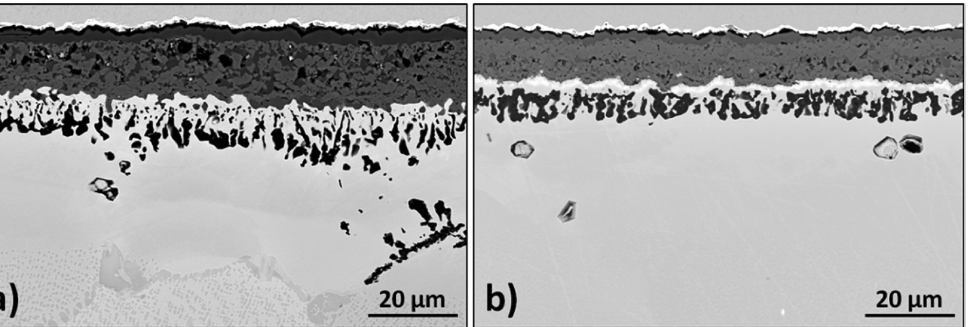
Figure 9: SEM/BSE images showing comparison of the oxides formed on (a) Rene 80 and (b) IN 792 during isothermal oxidation test at 1,050°C for 50 h in Ar – 20% O